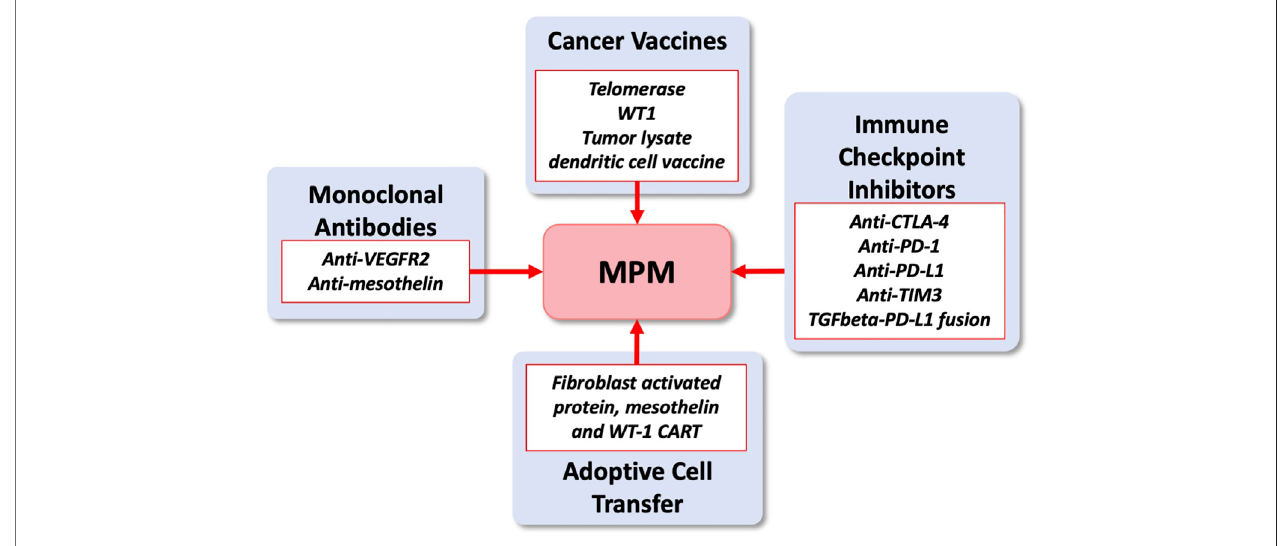
FIGURE 4 | Immunotherapy treatments under investigation in MPM. Ongoing and planned clinical trials in MPM (see